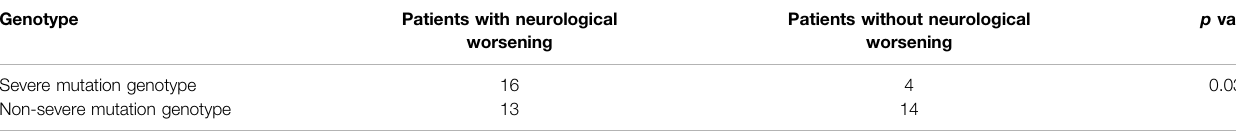
TABLE 2 | Comparison of genotype in patients with and without neurological